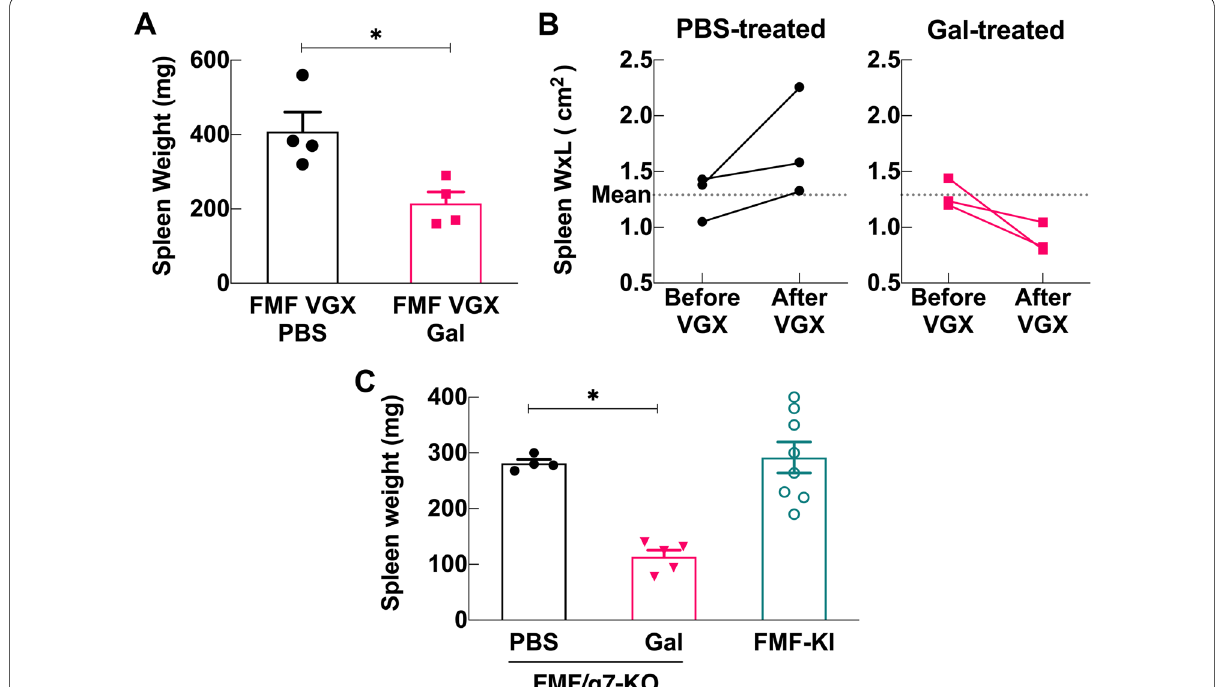
Fig. 4 Galantamine controls splenomegaly in vagotomized (VGX) and α7nAChR knocked‑out FMF‑KI (FMF/α7‑KO) mice. A Spleen weights (mg) from galantamine‑ and PBS‑treated vagotomized mice after ~ 4 weeks of treatment. B Spleen area (Width x Length cm 2 ) before abdominal VGX (measured intra‑operatively during VGX procedure) compared to area after 4 weeks of galantamine or PBS treatment. C Spleen sizes (mg) from galantamine‑ and PBS‑treated α7nAChR deficient FMF‑KI mice after 4–6 weeks of treatment with galantamine (escalated to 12 mg/kg twice daily) starting at age ~ 4–5 weeks (treated n 5; control n 4). Spleen weights (mg) from α7‑intact mice at ~ 9–10 weeks of age (historical) are included = = for comparison only. Data presented as mean SEM; * P < 0.05 by Mann–Whitney U ±